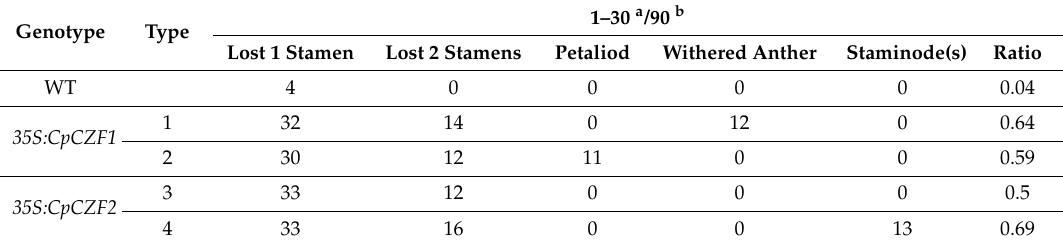
Table 2. Statistical results of the abnormal stamens in wild type (WT) and overexpression